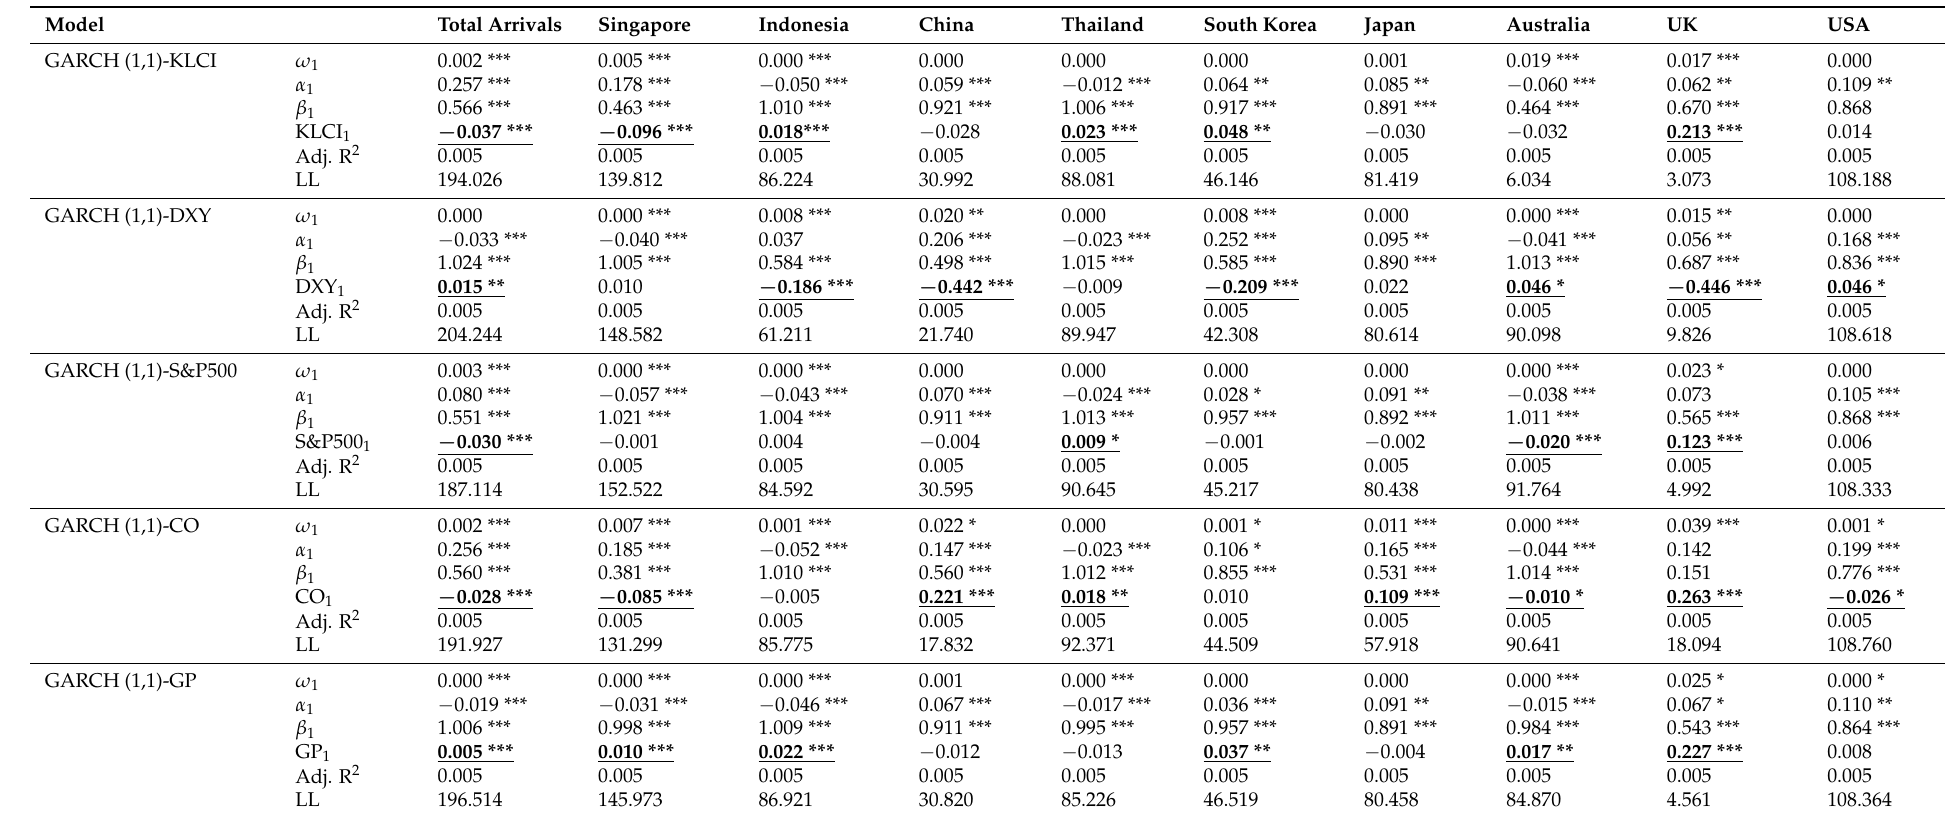
Table 7. Conditional variance equation for GARCH model with financial news